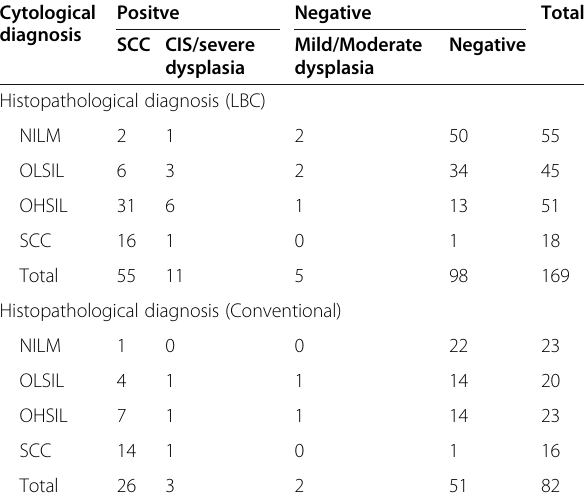
Table 2 Results of cytological diagnoses in comparison with histopathological diagnoses